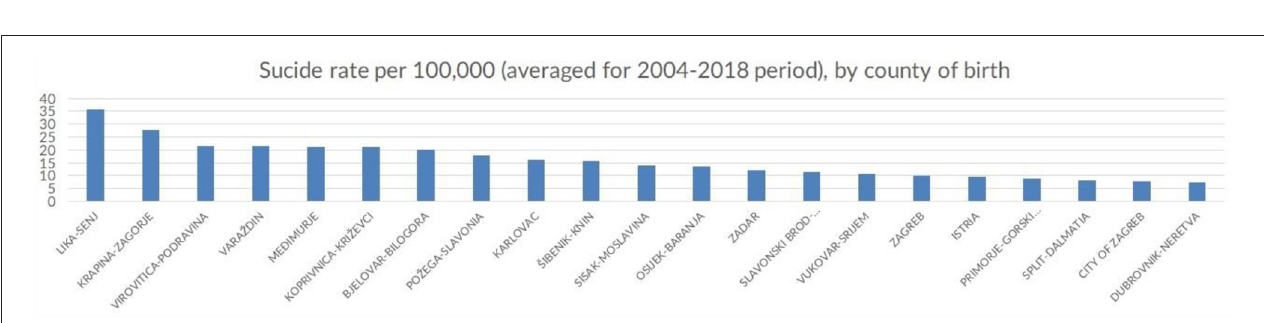
FIGURE 6 | Number of suicide cases per county of birth, in Croatia, (averaged across the observed period), 2004-2018 (Croatia,